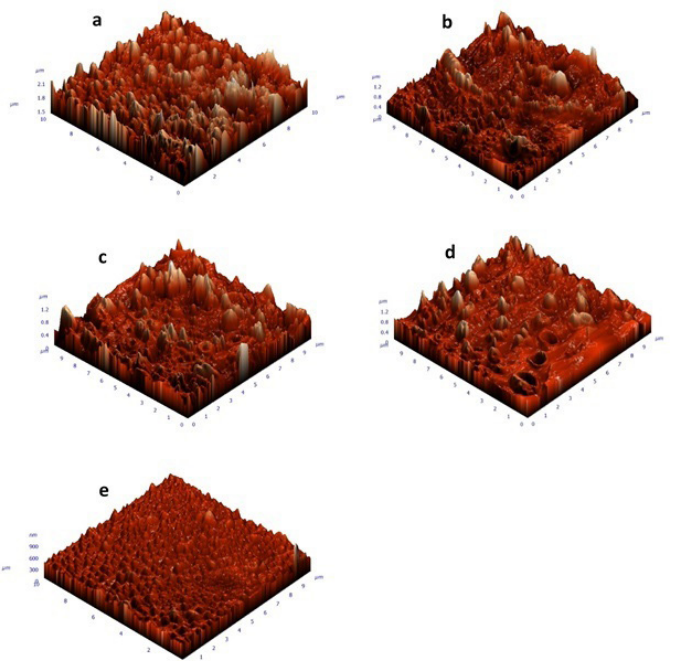
Figure 12. AFM images of mild steel after 8 h immersion in 0.5 M HCl containing different concentrations of TTA (a) blank, (b) 0.01 M, (c) 0.03 M, (d) 0.05 M, (e) 0.07